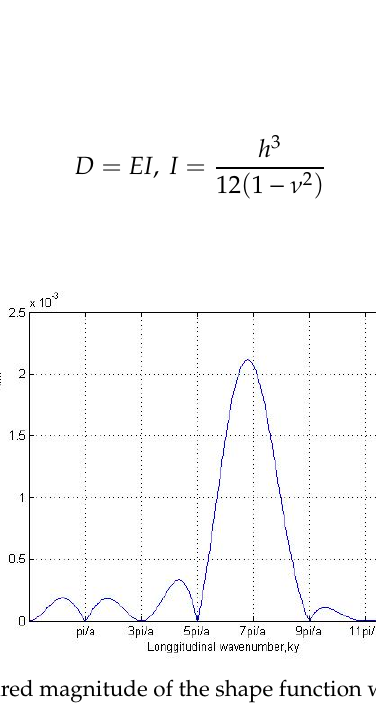
Figure 14. Squared magnitude of the shape function with m = 7, k x = 0.